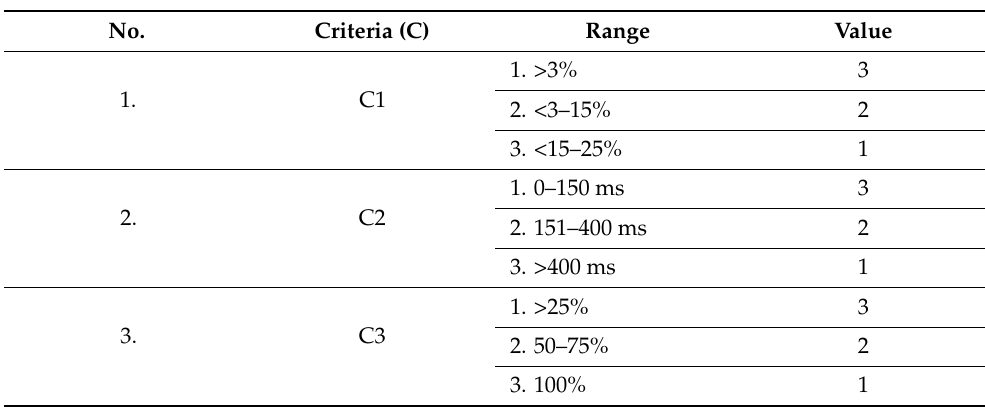
Table 9. Value of sub